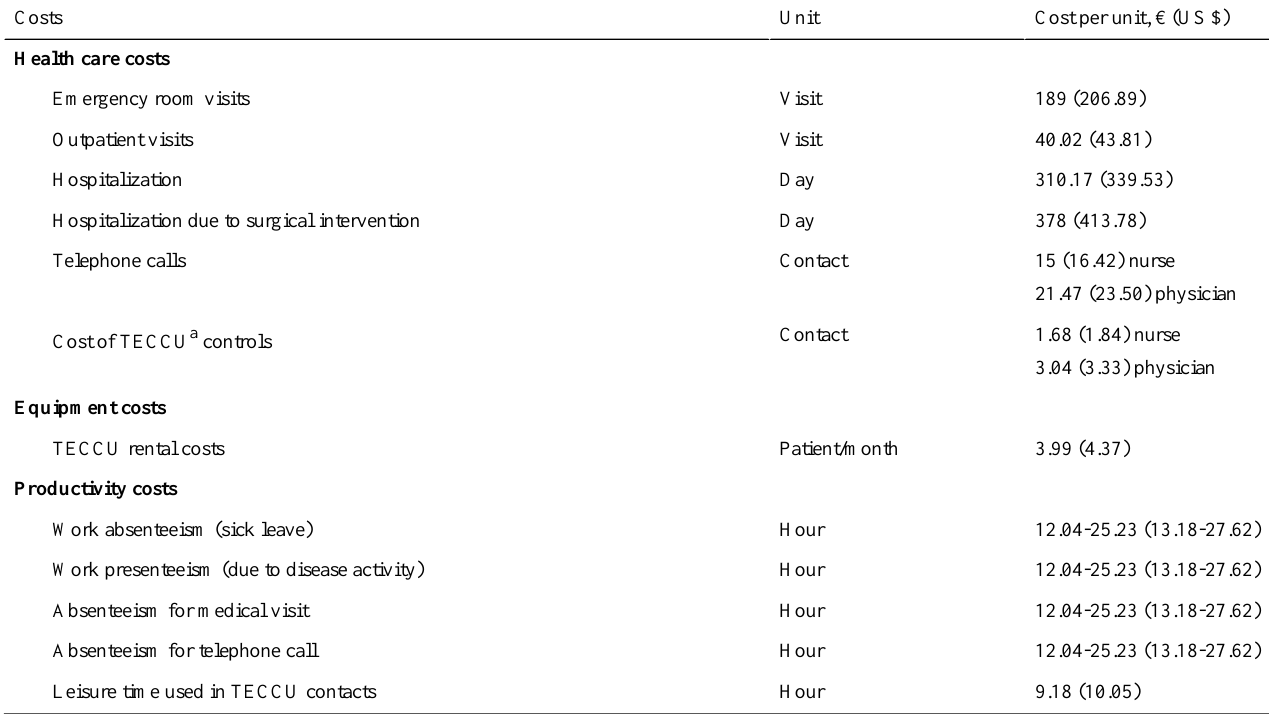
Table 2. Costs per unit of health care resources, equipment, and productivity and social